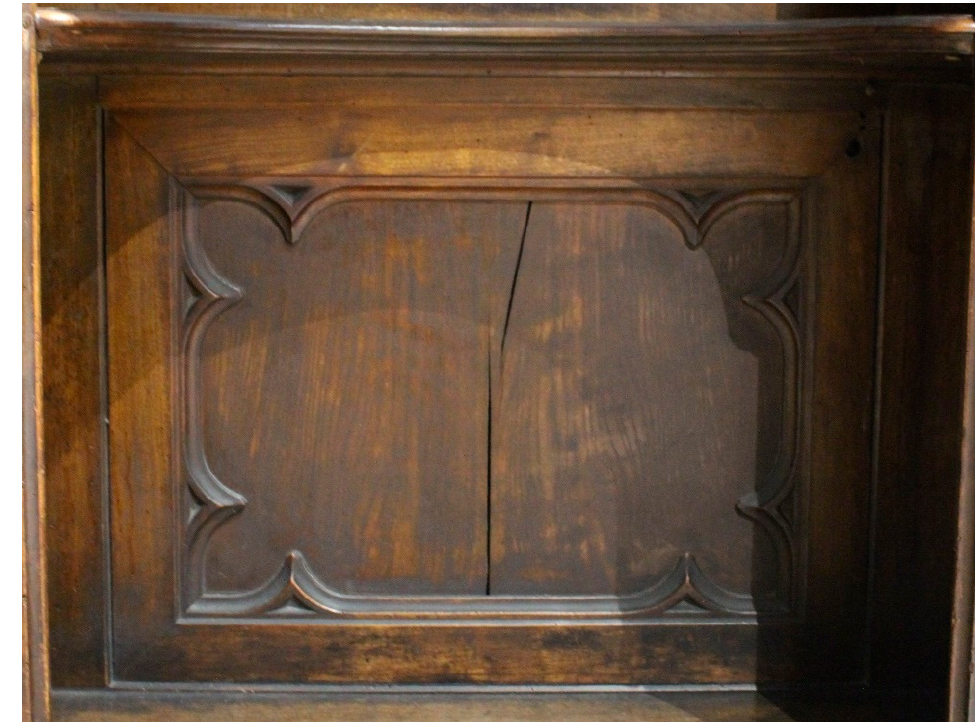
Figure 18. Confessional with already ongoing deterioration process.